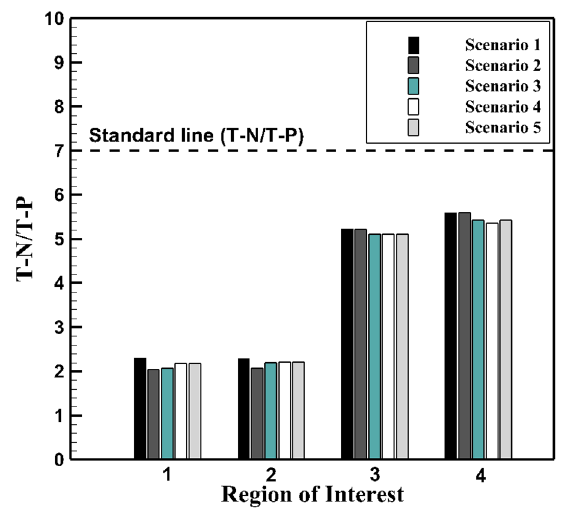
Figure 12. Ratio of total nitrogen to total phosphorus at the regions of interest (dash line is the standards to use the only T-N standards) Table 9. Evaluation of water quality at ROI according to